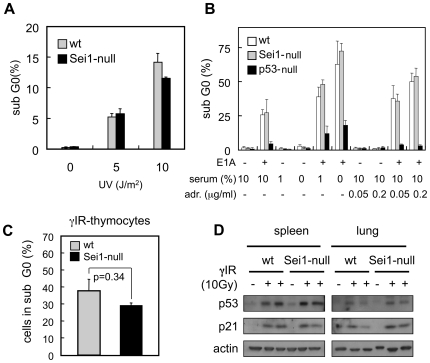
Apoptosis in Sei1-null cells.
(A and B) Three independent preparations of primary MEFs per genotype were either irradiated with the indicated doses of UVC (A), or transduced with E1A and treated with low serum conditions or with adriamycin, as indicated (B). Apoptosis was measured by quantifying subG0 DNA content by FACS. (C) Thymocytes from three mice per genotype treated with 10 Gy of γ-radiation were isolated and apoptosis was measured 3 h post-radiation, as in (A) and (B). (D) Protein extracts of lung and spleen from the same irradiated mice as in (C) were immunoblotted against p53 or its target p21Cip1. Actin was used as a loading control.